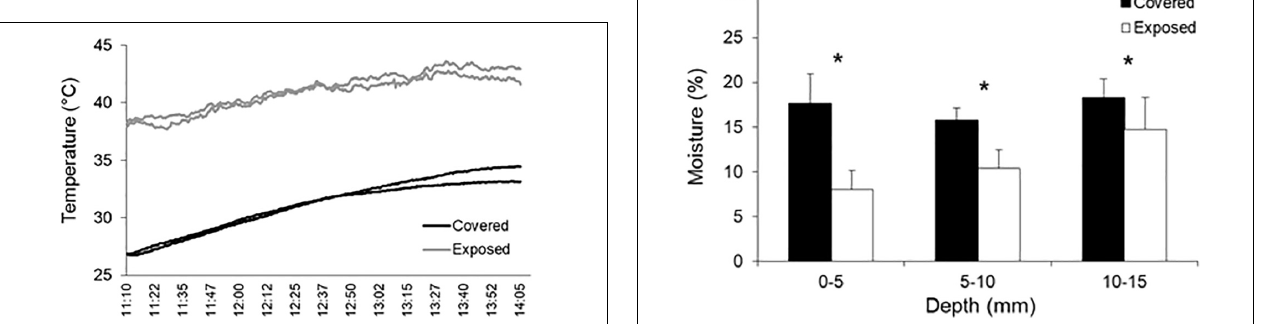
FIGURE 3 | Substrate moisture content (water mass as a percentage of sample mass) of mussel-covered and mussel-removal (exposed) bench materials at three depth ranges. Substrate samples were collected on a clear and exceptionally hot late-spring day (November 21, 2018) 2.5–3 h after the tide had receded and the platform was air-exposed. The vertical lines above the bars indicate 1 SD. Asterisks indicate significant treatment effects at the corresponding depth level ( p <